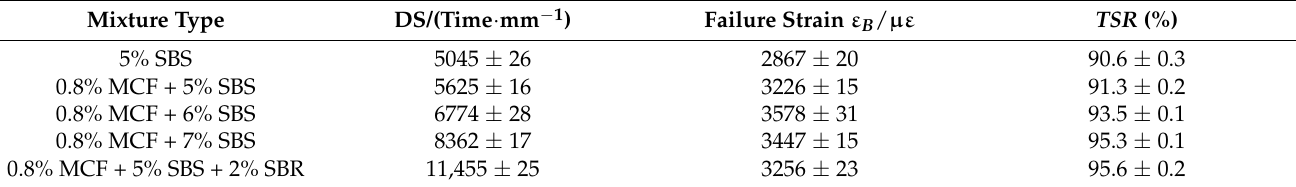
Table 9. High-temperature, low-temperature, and water stability test results.